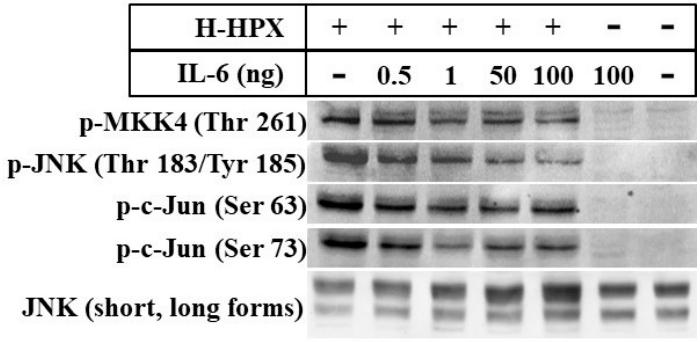
Figure 2. IL-6 crosstalk decreases JNK pathway component levels induced by heme-HPX. The data are from immunoblot analyses of cell extracts (40 µ g protein / lane, as described in the legend to Figure 1). After incubation of Hepa cells with 5 µ M heme-HPX in the presence or absence of IL-6 at the concentrations shown, for 30 min, IL-6 (1.0–100 ng / mL) consistently decreased to 54.3% the levels of p-MKK4 (mean +/ − SD of three highest IL-6 concentration datasets: 58.63 +/ − 6.21; 49.97 +/ − 9.66). The IL-6 also decreased p-JNK levels to 60.4% (mean +/ − SD of three highest IL-6 concentration data sets 56.25 +/ − 11.56 and 64.5 +/ − 4.96). These data show that IL-6 decreases the levels of key kinases of the JNK pathway activated by heme-HPX in Hepa cells. The data shown are from a representative experiment of two independent biological replicates. Kendall’s tau and Spearman’s rho rank correlation analyses were used for the statistical analyses of the relationship between IL-6 concentrations and the levels of p-MKK4 and p-JNK as described in the